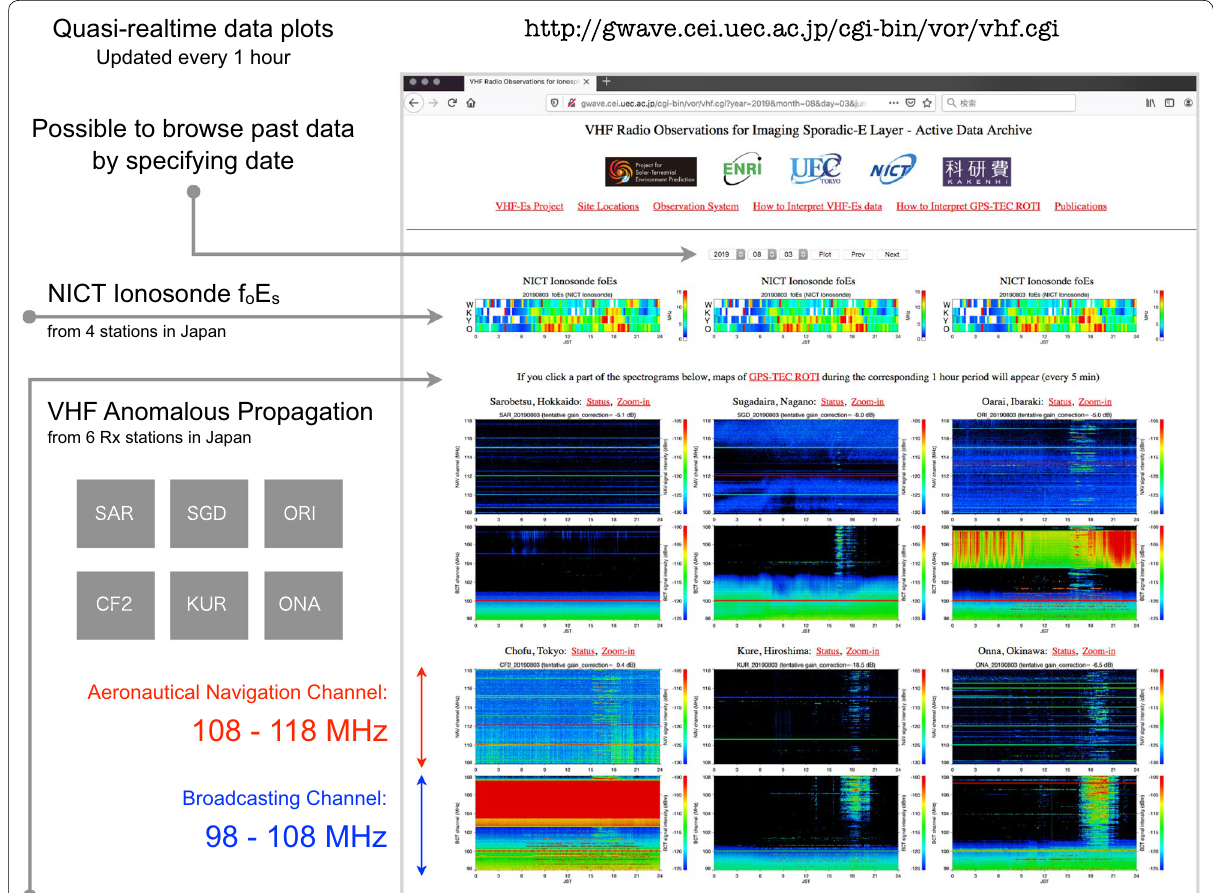
Fig. 7 Near real-time data browsing system for the Es-related anomalous